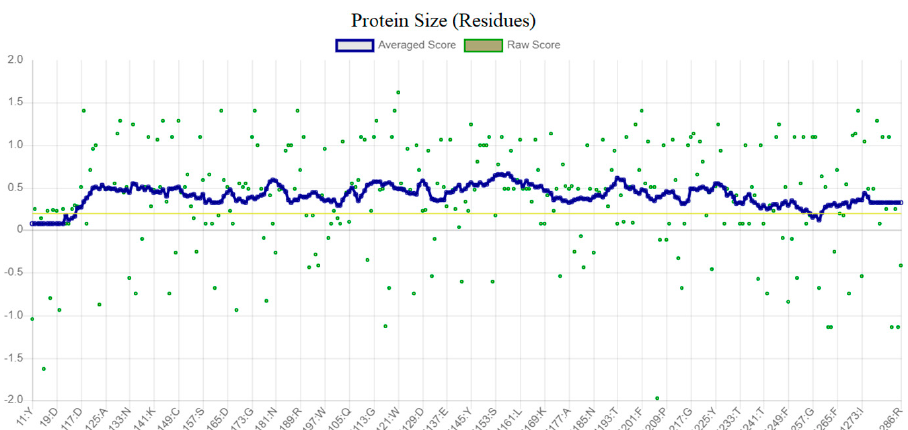
Figure 1. Ramachandran plot of protein obtained by homology. ( □ ) Non-glycine and non-proline residues; ( ∆ ) Number of glycine residues.